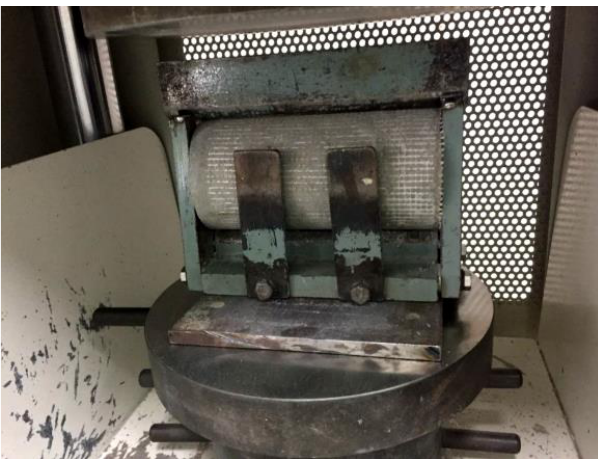
Figure 6. Setup for the splitting tensile test.